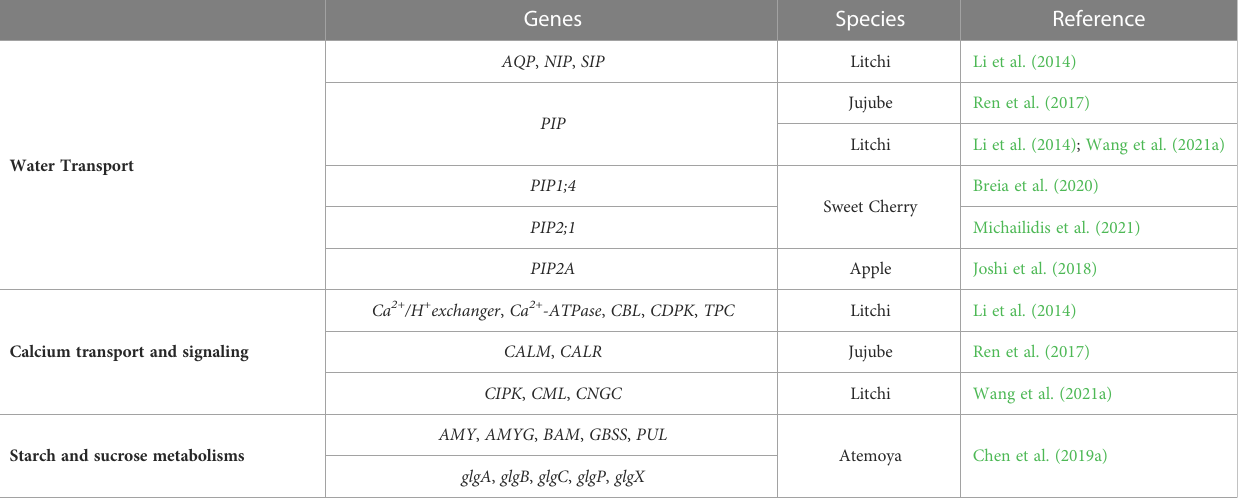
TABLE 4 Potentially cracking-related genes involved in water transport, calcium transport and signaling, and starch and sucrose